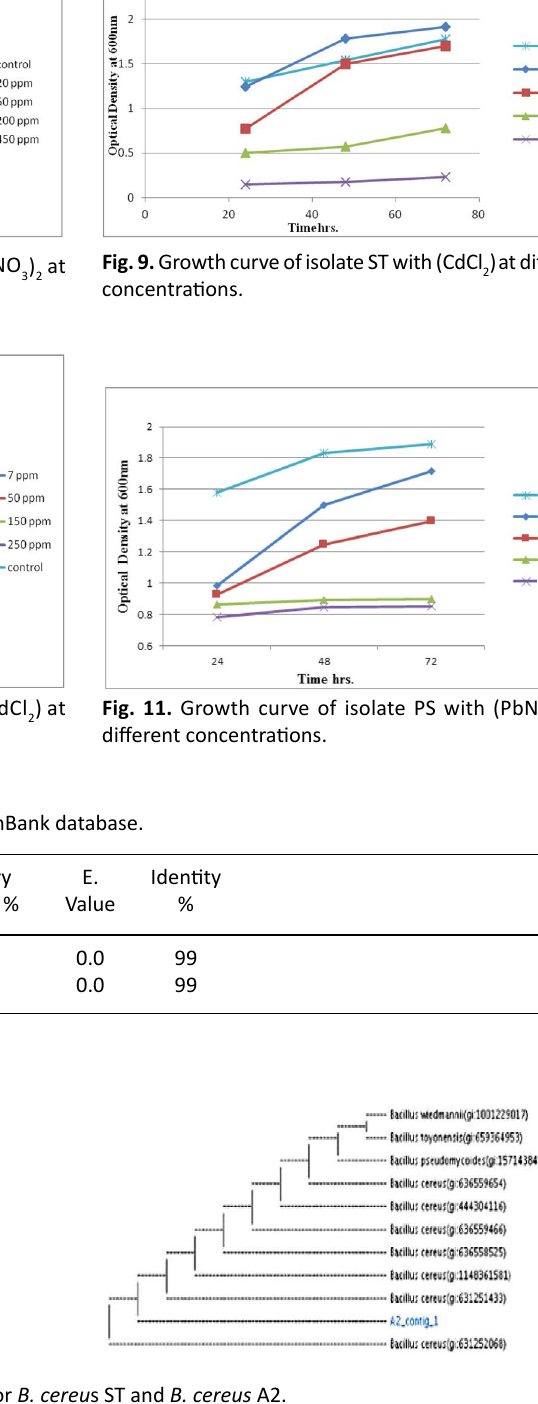
Fig. 12. Phylogenetic tree based on 16S rRNA for B. cereu s ST and B. cereus A2.